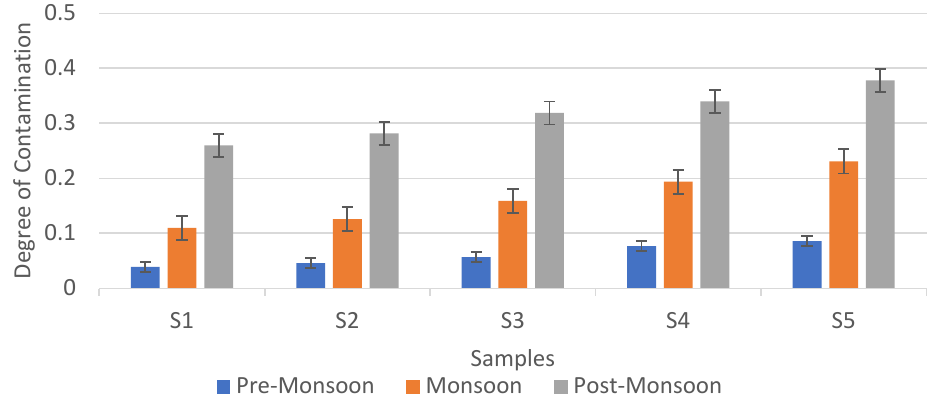
Fig. 5: Contamination degree in various